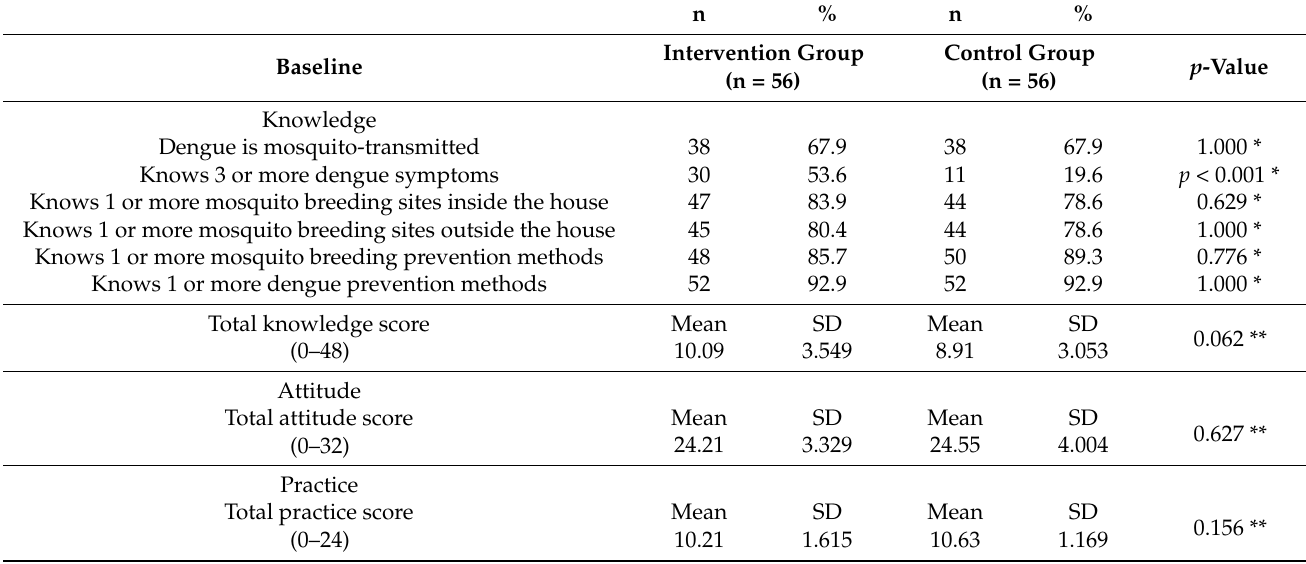
Table 3. Dengue knowledge, attitudes, and practice based on intervention and control groups (baseline). “n” indicates the number of persons that answered ‘yes’ to the question).